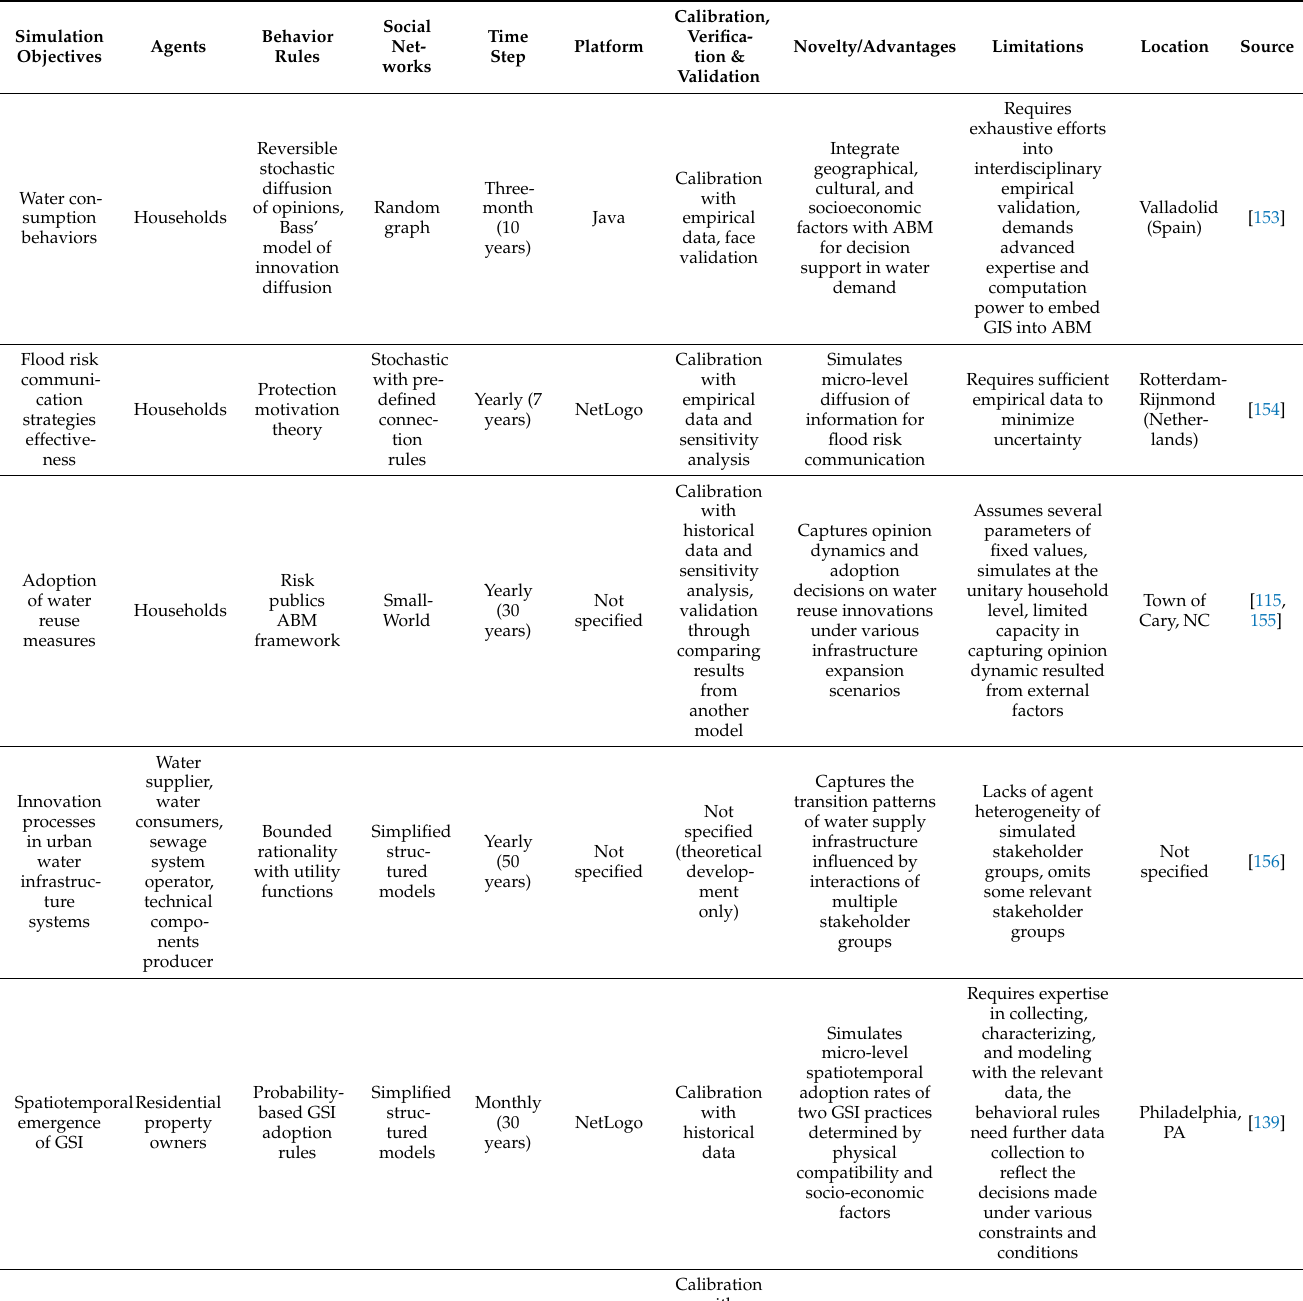
Table 3. Innovative strategy diffusion in water management using